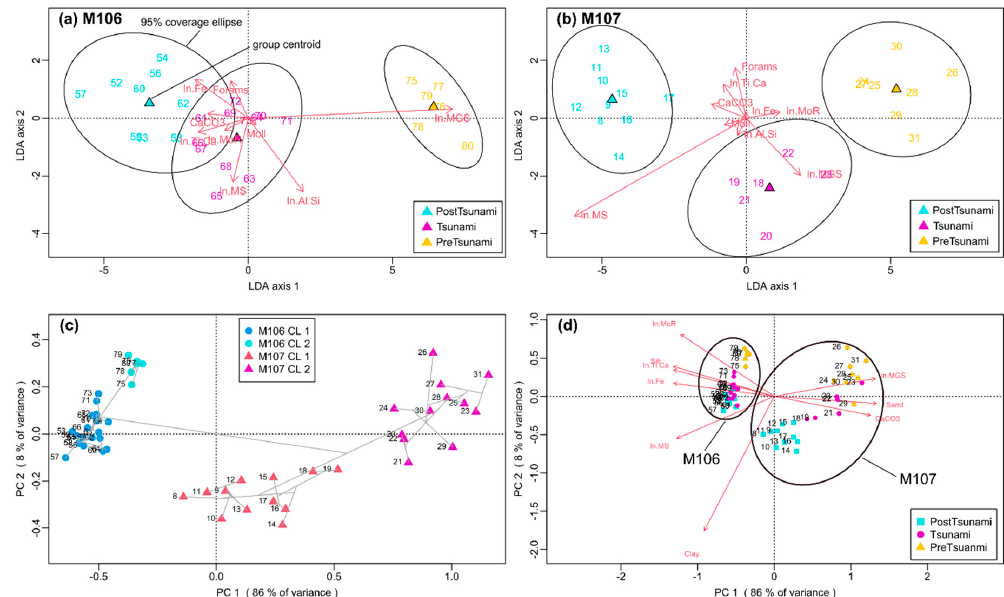
Figure 8. Results of the multivariate statistics of the supporting data. The numbers correspond to the sample depth (cm). ( a , b ) First and second LDA-axes of core M106 showing the 3 group classification (pre-tsunami, tsunami, and post-tsunami) of core M106 explained by the supporting data set (Forams = benthic and planktonic foraminifera, Moll = mollusks, ln.MS = log-transformed magnetic susceptibility, ln.MGS = log-transformed mean grain size and log-transformed XRF elemental counts/ratios. ( c ) PCA-biplot (scaling 1) with overlaid HCL results including samples of core M106 and M107. ( d ) PCA-biplot (symmetrically scaled by the square root of eigenvalues) showing samples of core M106 and M107 and the variables (red arrows: length proportional to contribution). The samples are coloured for their respective chronological group.